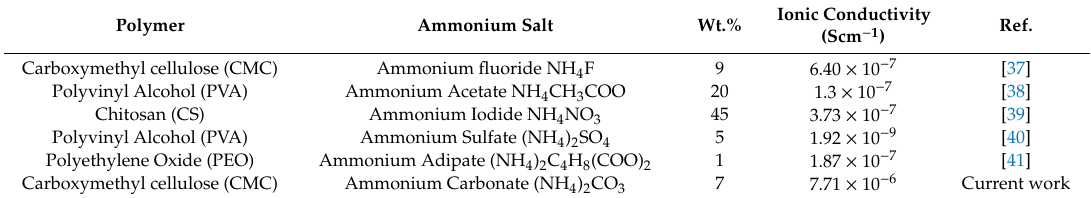
Figure 3. ( a , b ) Impedance plot for CMC-AC biopolymer films and ( c ) the ionic conductivity of CMC-AC biopolymer films ( d ) ionic conductivity at elevated temperature. Table 3. Ionic conductivity comparison of polymer with ammonium salt system measured at room temperature from literature and this work.